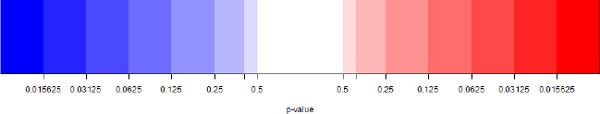
p-value based breaks. A color-scale based on p-value-based cut-offs. Increasingly more saturated hues are associated with lower p-values. The color is based on the sign of the t-statistic.